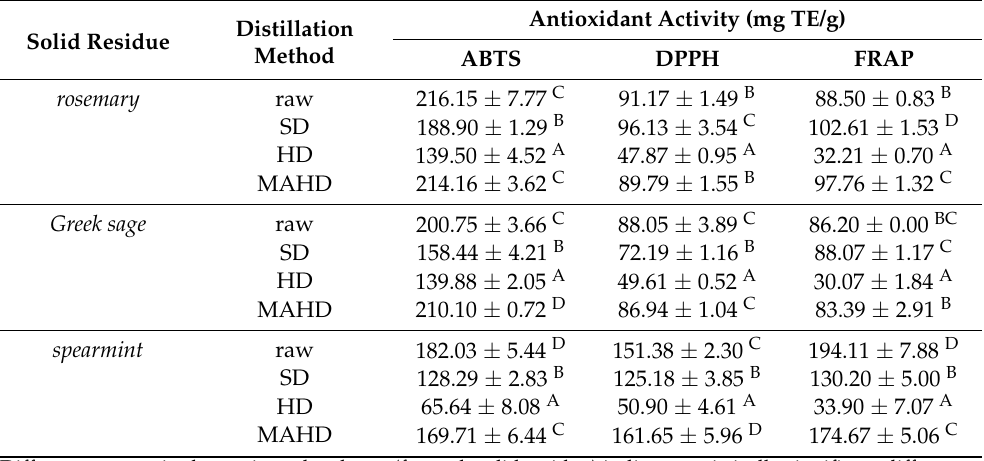
Table 1. In vitro antioxidant activity of methanolic extracts of rosemary, Greek sage and spearmint dis- tillation solid residues after the recovery of essential oils by steam-distillation (SD), hydro-distillation (HD) and microwave-assisted hydro-distillation